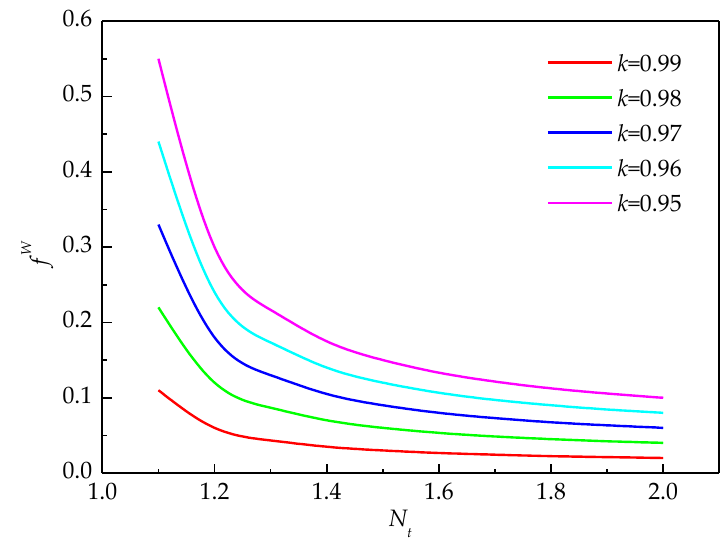
Figure 8 . The relationship between f W and N t .